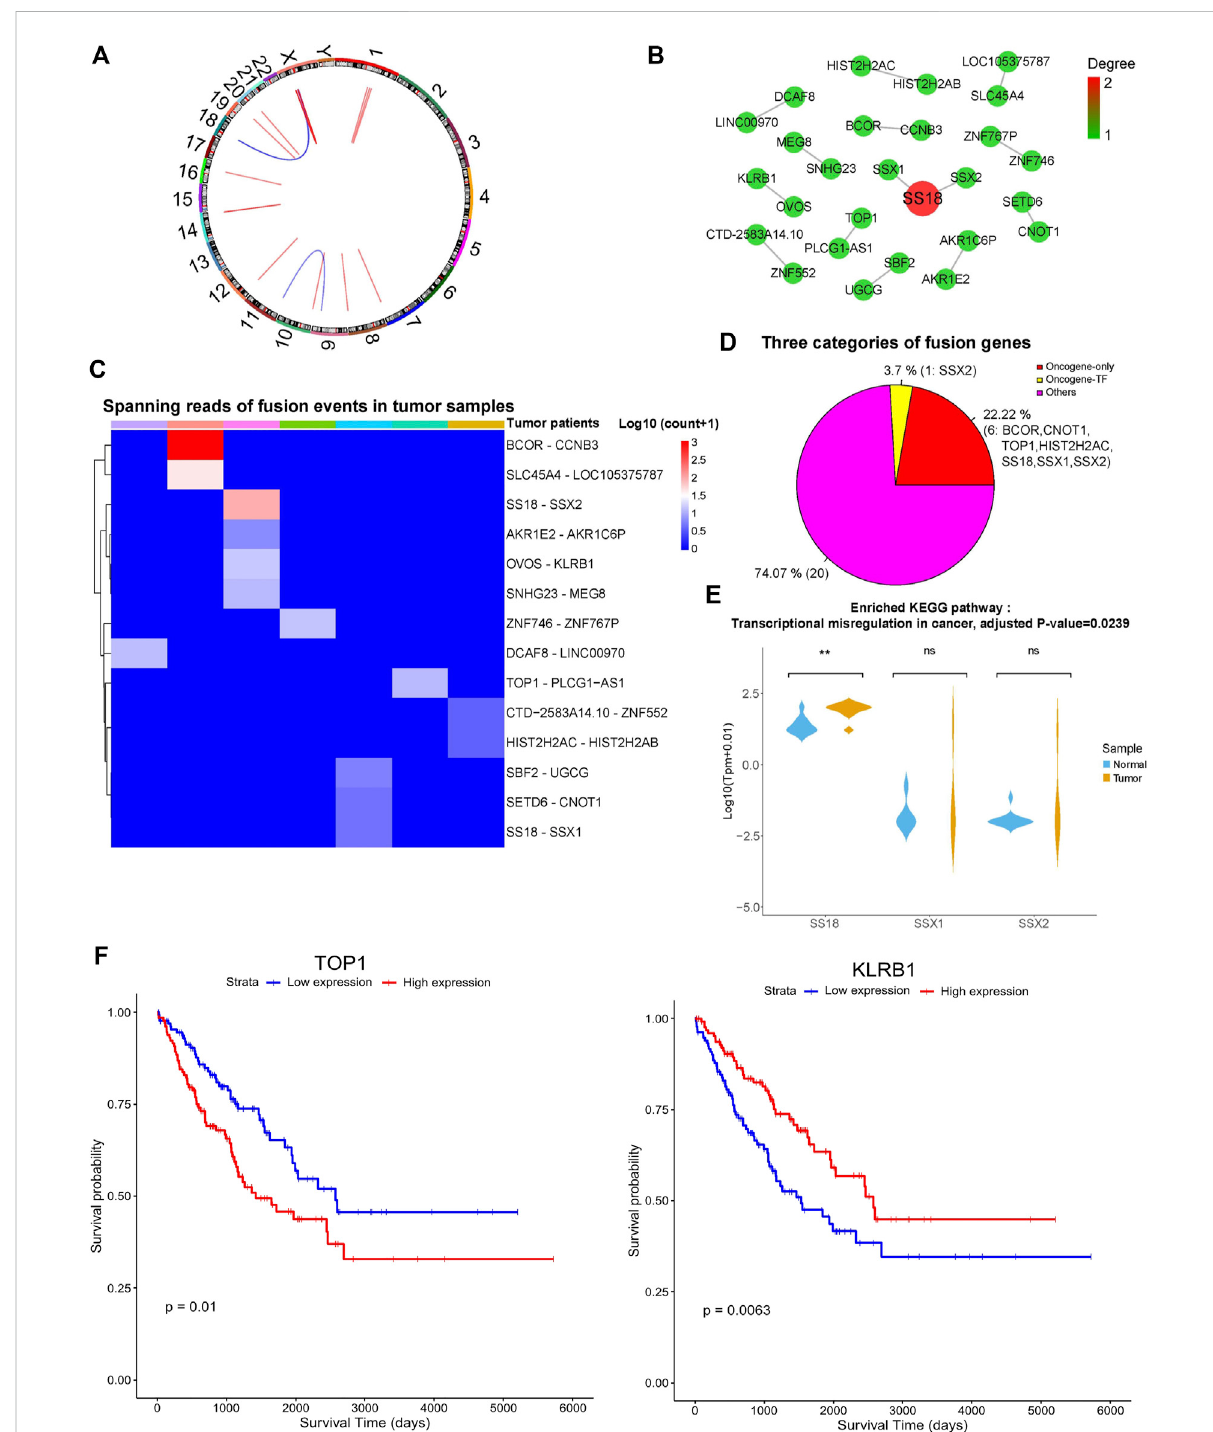
FIGURE 3 Gene fusion landscape of SS. (A) Circos plot showing the 14 tumor-speci fi c fusion pairs in SS. (B) Network of tumor-speci fi c fusion genes. The sizeandcolorofeachcirclecorrespondtothedegreeoffusionedges. (C) Heatmapdisplayingthesupportingjunctionreadsfortumor-speci fi cgene fusions. (D) Different categories ofthe fusion genes. (E) Expression pro fi le of thefusion genes involved insigni fi cantly enriched biological processes. Adjusted p -value < 0.05. (F) The fusion genes signi fi cantly correlated with the survival of TCGA sarcoma patients. p -value <